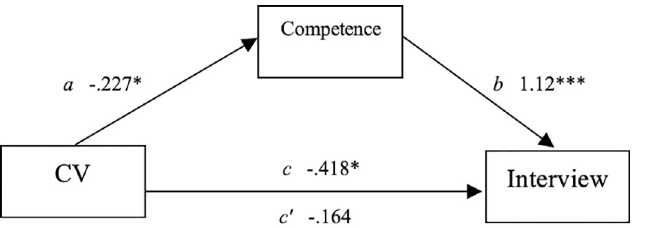
Fig 1. Unstandarized regression coefficient for the relationship between CV and interviews as mediated by competenence.